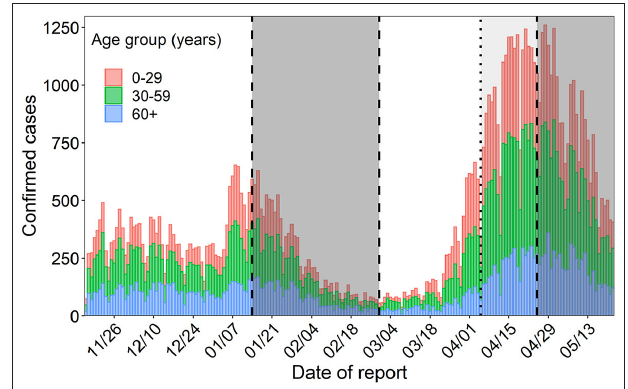
FIGURE 1 | Incidence over time in Osaka. The colors of the bars represent age group. The gray shaded area signifies the state of emergency period and the area shaded in light gray represents the pre-emergency measures